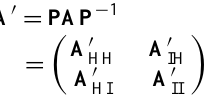
Table 3. Statistical and systematic errors in the Iza˜na total H 2 O col- umn due to the assumed experimental and temperature uncertainty sources of Table 2. The Total (TOT) data represents the root-square- sum of these errors. In addition the error due to the limited verti- cal sensitivity and resolution of the remote sensing system is given (smoothing error).